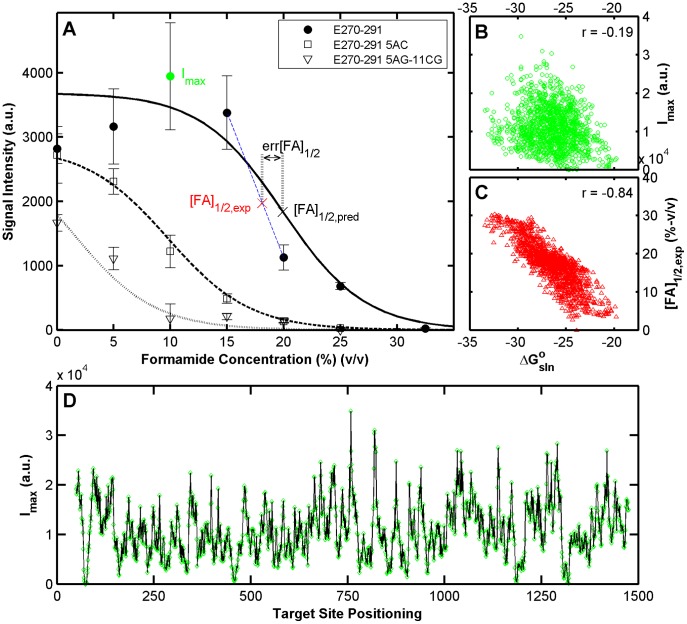
Characteristics of formamide denaturation profiles.(A) Example formamide curves with perfect match, one-mismatch, and two-mismatch probes targeting the same site on 16S rRNA gene of E. coli. Curves represent theoretical profiles. Observed maximum signal intensity (Imax), experimental ([FA]1/2,exp) and predicted ([FA]1/2,pred) half-denaturation points, and the prediction error (err[FA]1/2) are illustrated. [FA]1/2,exp is estimated by linear interpolation between two subsequent experimental points that are greater than and less than Imax/2, respectively. Panels (B) and (C) show the correlation of solution-based free energy predictions with Imax and [FA]1/2,exp, respectively, with r defining the Pearson’s correlation coefficient. (D) Imax plotted against position of target site, as represented by the middle point. All data were obtained from probes belonging to the TileE set (Table 1). Amount of hybridized target was 5 ng.